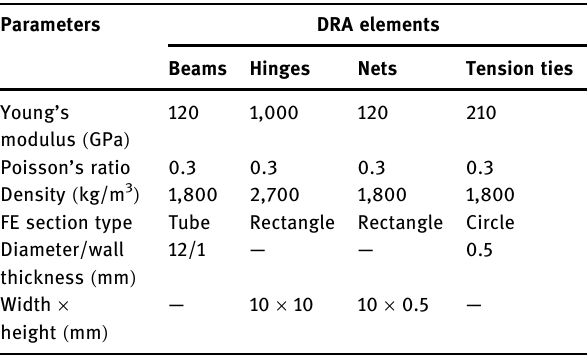
Figure 10: RW con fi guration.